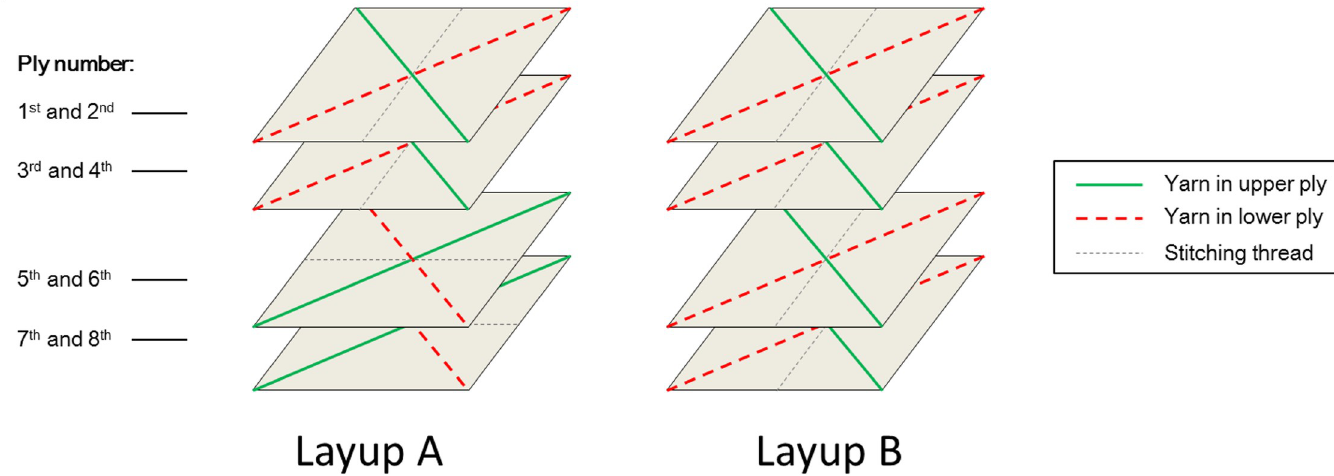
Fig 3. Schematic illustration of the layup configurations in the fabricated multiaxial composite laminates with layup A and layup B. The laminates are made from 4 sheets of biaxial fabric, each consisting of two plies, giving 8 plies in total. In layup A, the two bottom fabric sheets are rotated in plane with an angle of 90˚ to the two top fabric sheets. In layup B, the four fabric sheets are placed on top of each other, without any rotation.